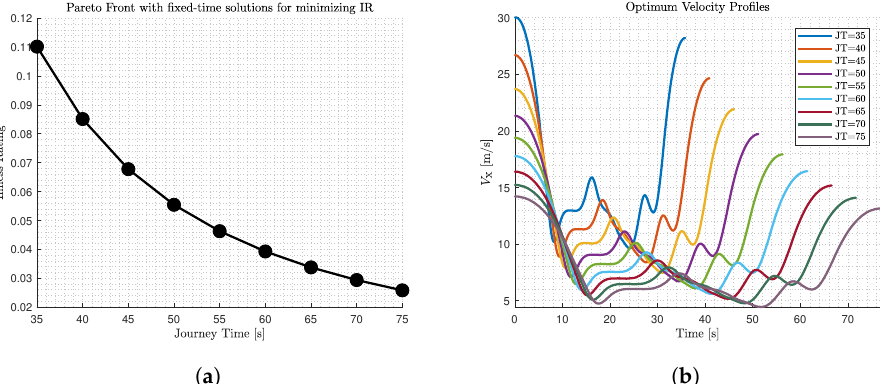
Figure 5. ( a ) The Pareto front with the optimal solutions obtained from the OCP for different fixed time cases ( T demand ) for the minimisation of IR and ( b ) their corresponding optimal velocity i